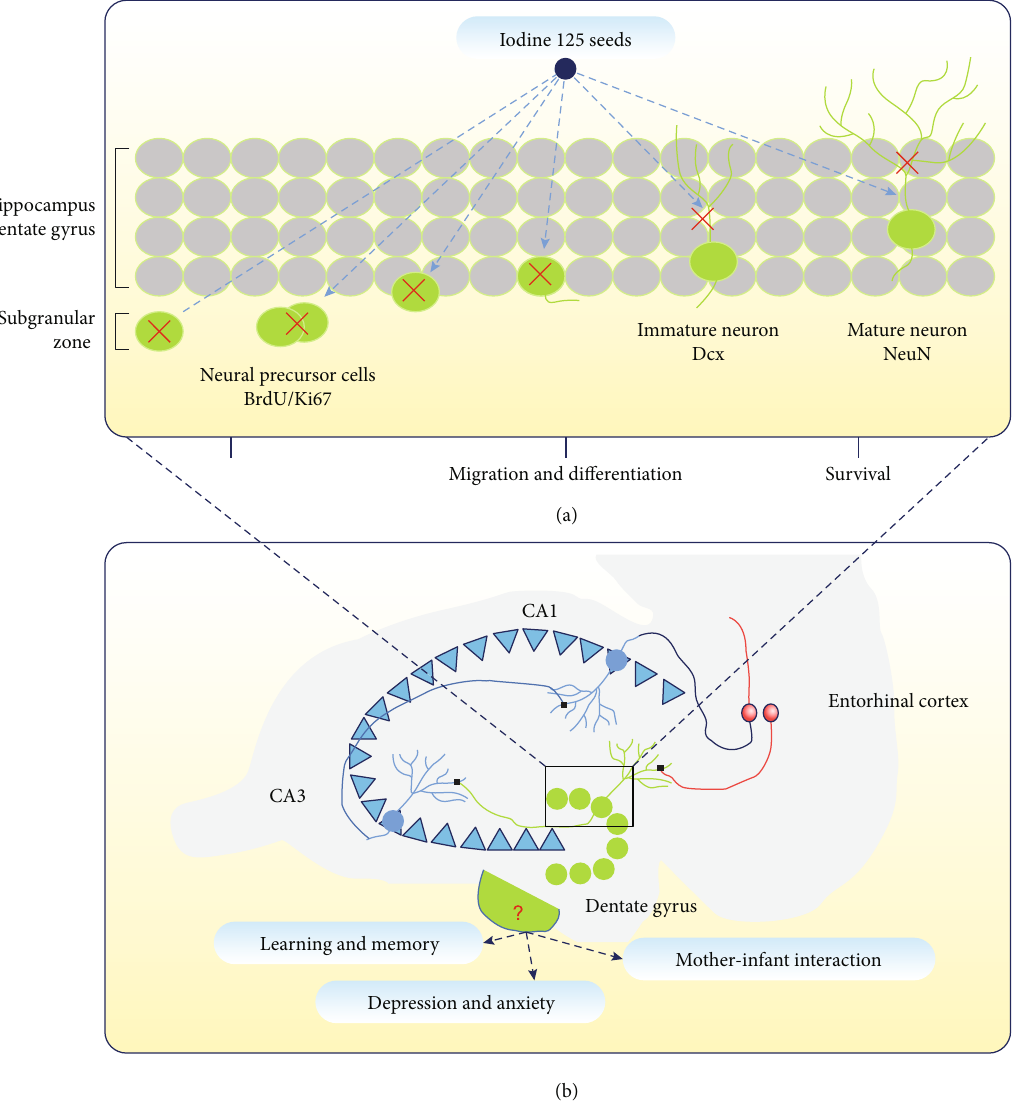
Figure 2: Schematic diagram of 125 I brachytherapy for ablation of hippocampal neonatal neurons (a), functional changes in hippocampus (b). Red crosses in (a) indicate ablation of newborn